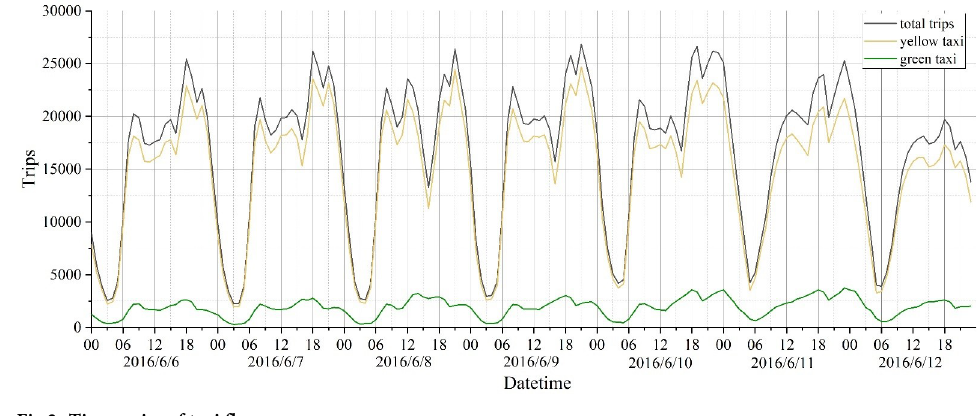
Fig 2. Time series of taxi